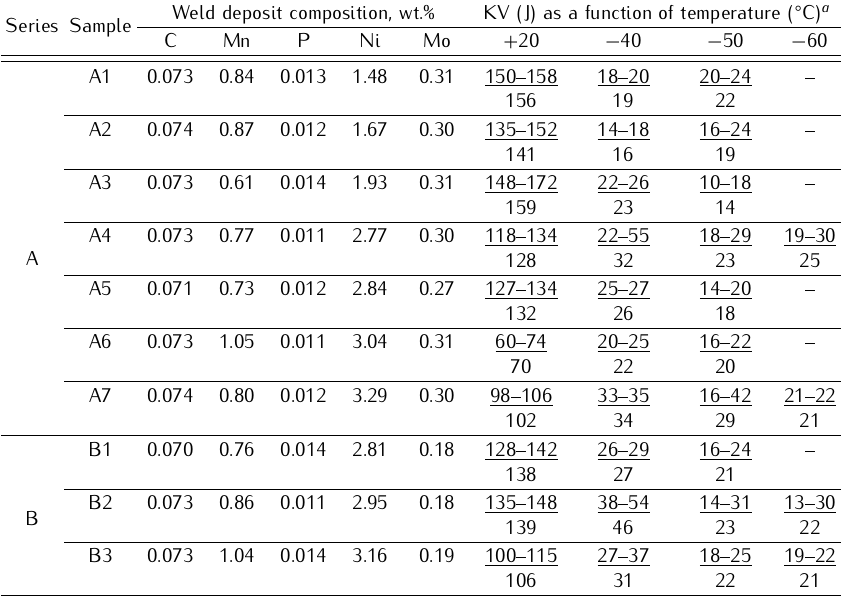
Table 3. Composition and impact energies of weld deposits of series A and B electrodes made with S1 cores. Series Sample